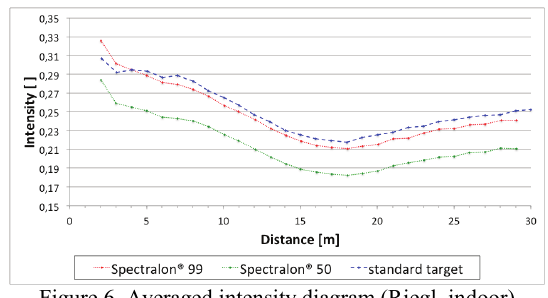
Figure 6. Averaged intensity diagram (Riegl, indoor)